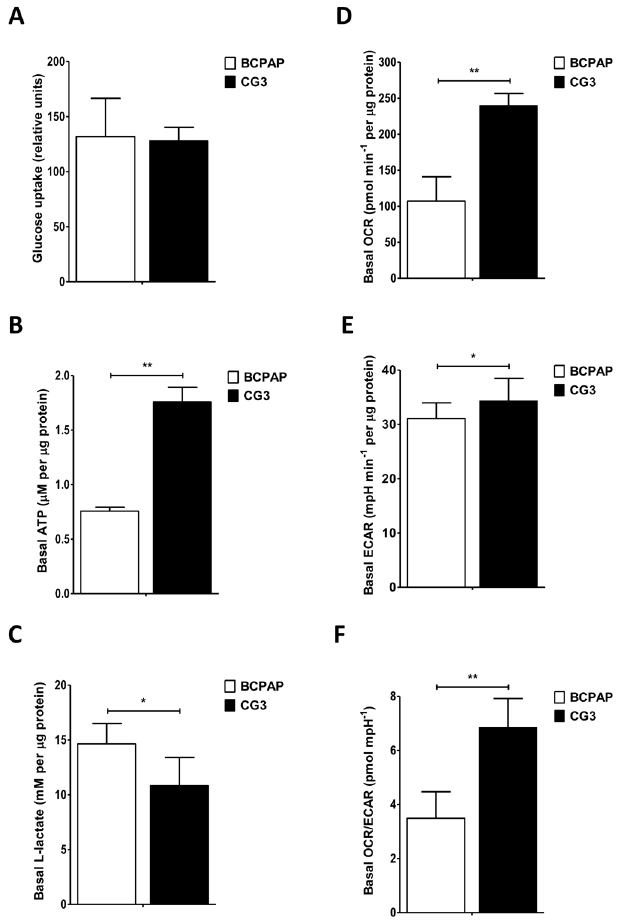
consumption rate (OCR). (E) Basal extracellular acidification rate (ECAR). (F) Basal OCR/ECAR ratio. Student ’ s t test was used to compare BCPAP and CG3 cells ( * p < 0.05, ** p < 0.001). Data are presented as means ± standard deviation